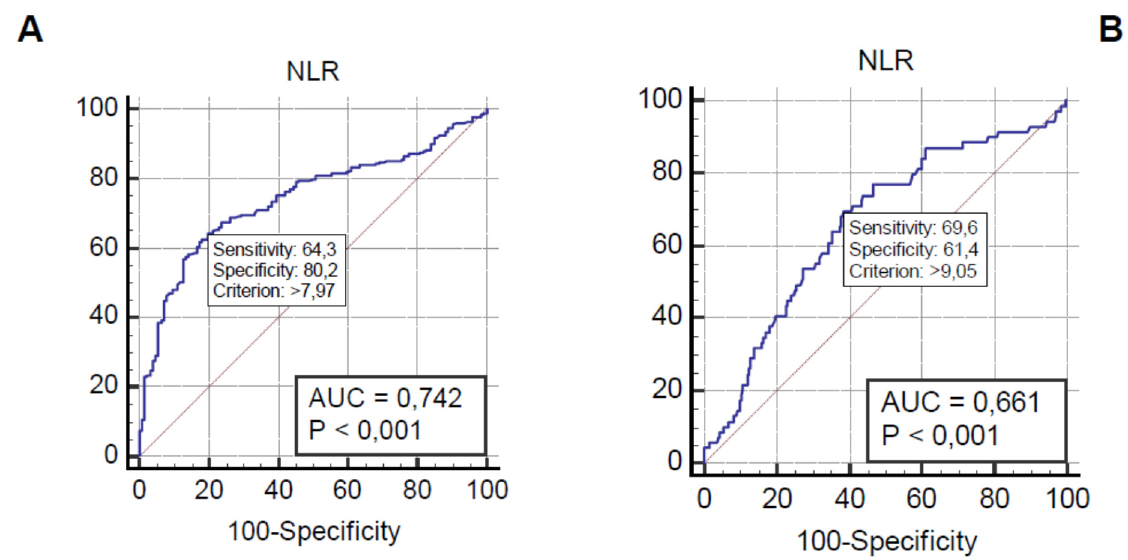
Figure 1. ( A ) Receiver operating characteristic (ROC) curve analysis, showing neutrophil-to-lymphocyte (NLR) ability to differentiate Scheme 7.97. ( B ) ROC curve analysis, showing NLR ability in to predict 90-day mortality in septic patients; the best value of NRL was 9.05. Table 2. Diagnostic role of NLR by ROC curve analysis.